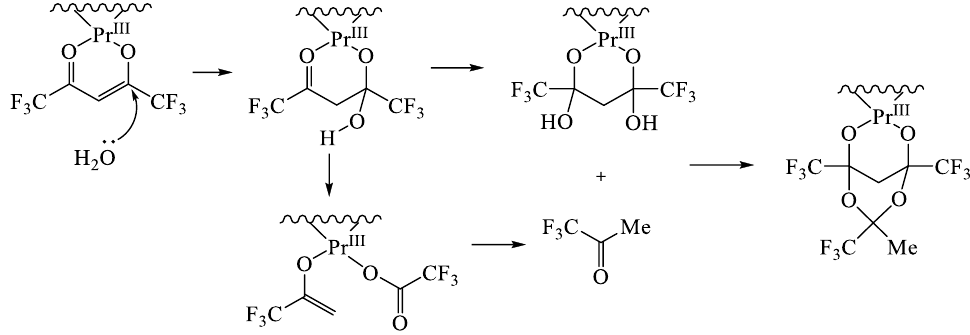
Scheme 35. Proposed mechanism for trifluoromethylated dioxane-diol